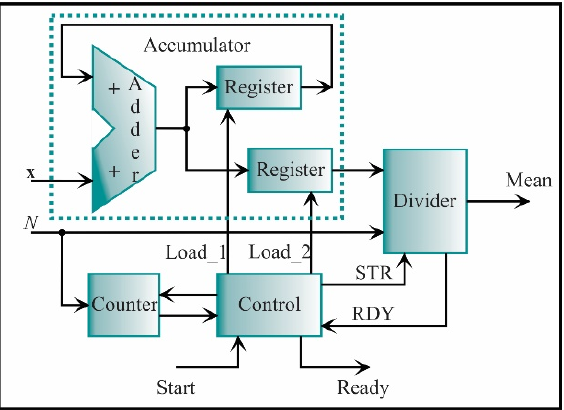
Figure 13. The architecture of the processing core for computing the mean.